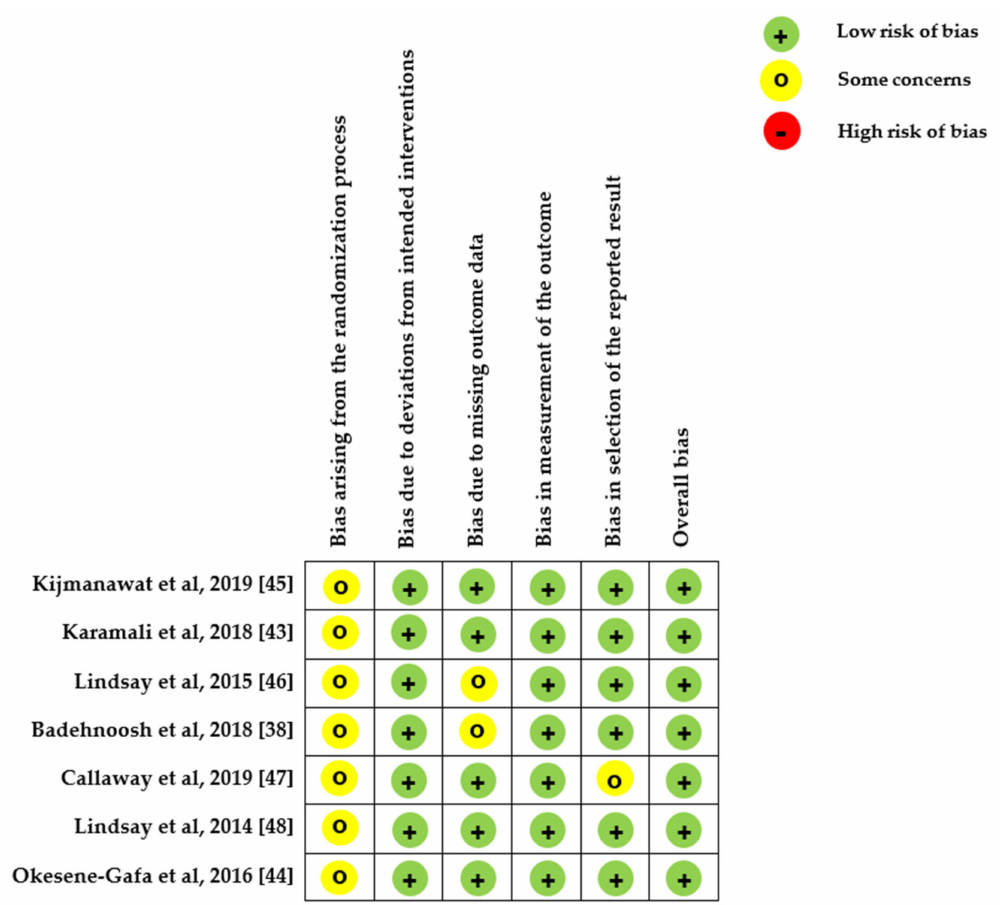
Figure 2. Quality assessment of the included studies conducted using RoB